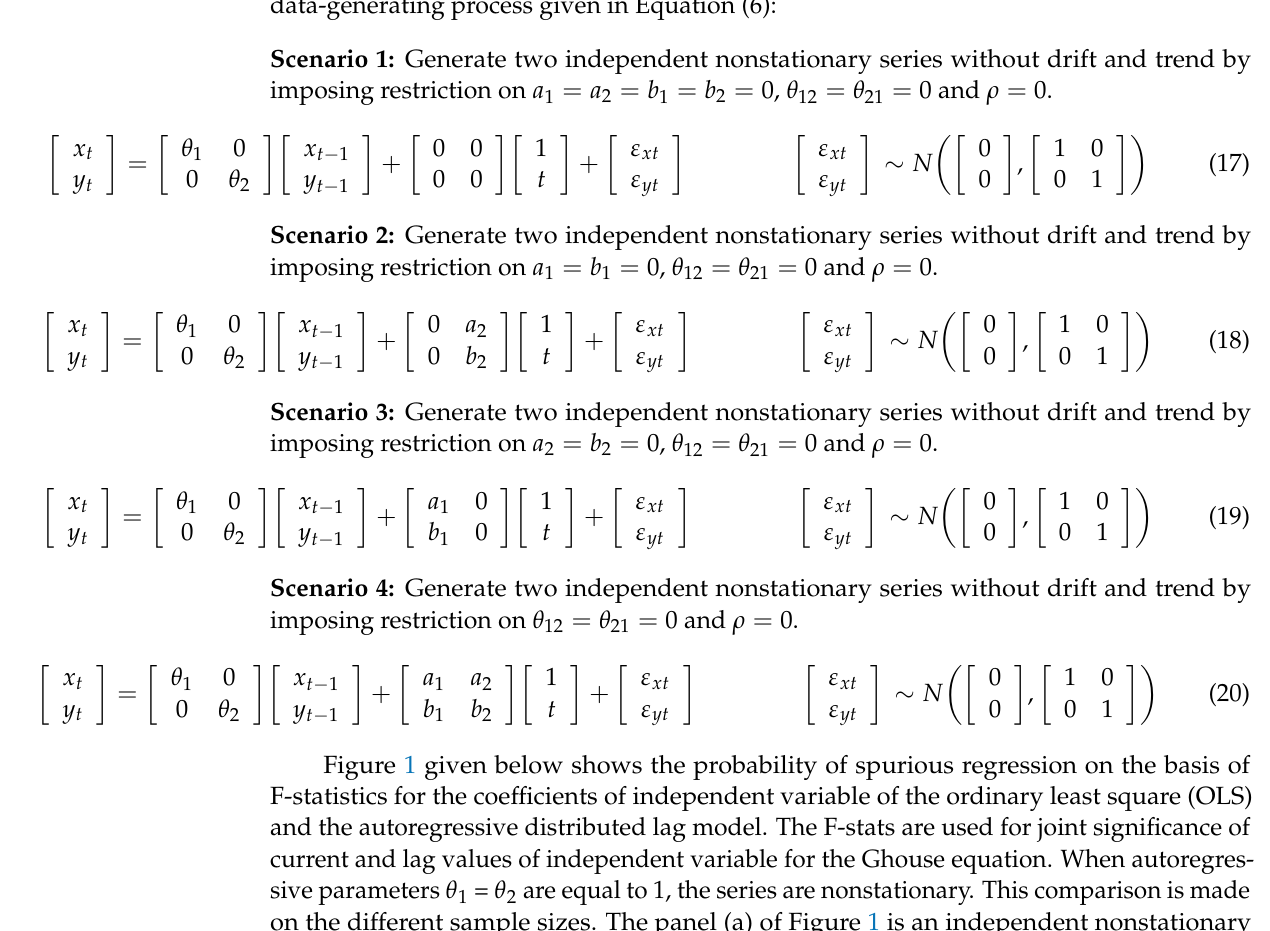
sive parameters θ 1 = θ 2 are equal to 1, the series are nonstationary. This comparison is